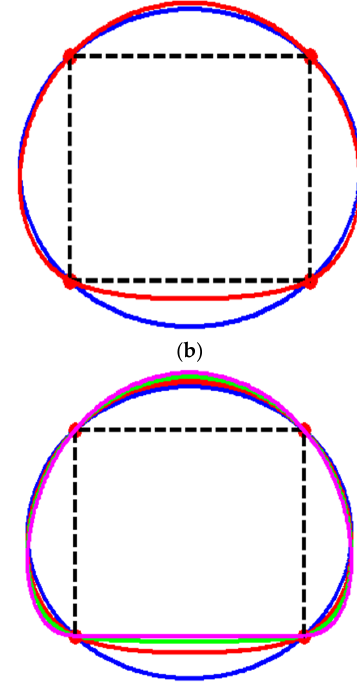
= σ = 2, 3, 5, and 100, for any k k k